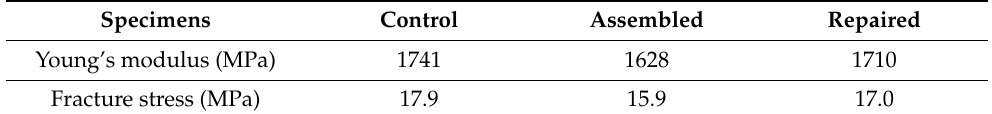
Table 6. Average tensile test results of different treatments of FEMA 3D 25 samples.